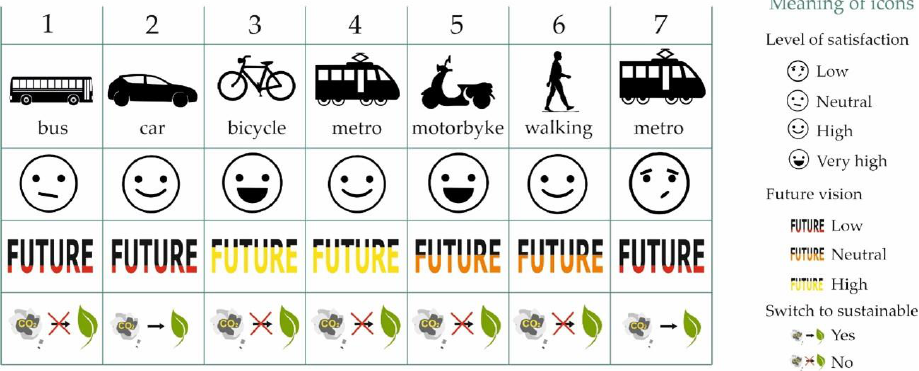
Figure 8. Summary of the characteristics of the clusters obtained.